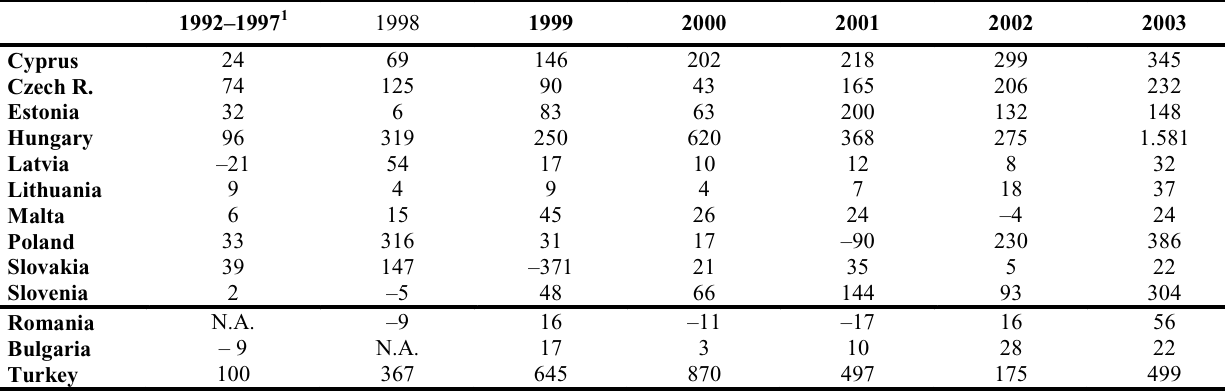
Table 7 . Comparison of Turkey with Romania, Bulgaria and the 10 new members of the EU in terms of FDI outflows between 1992 and 2003, million